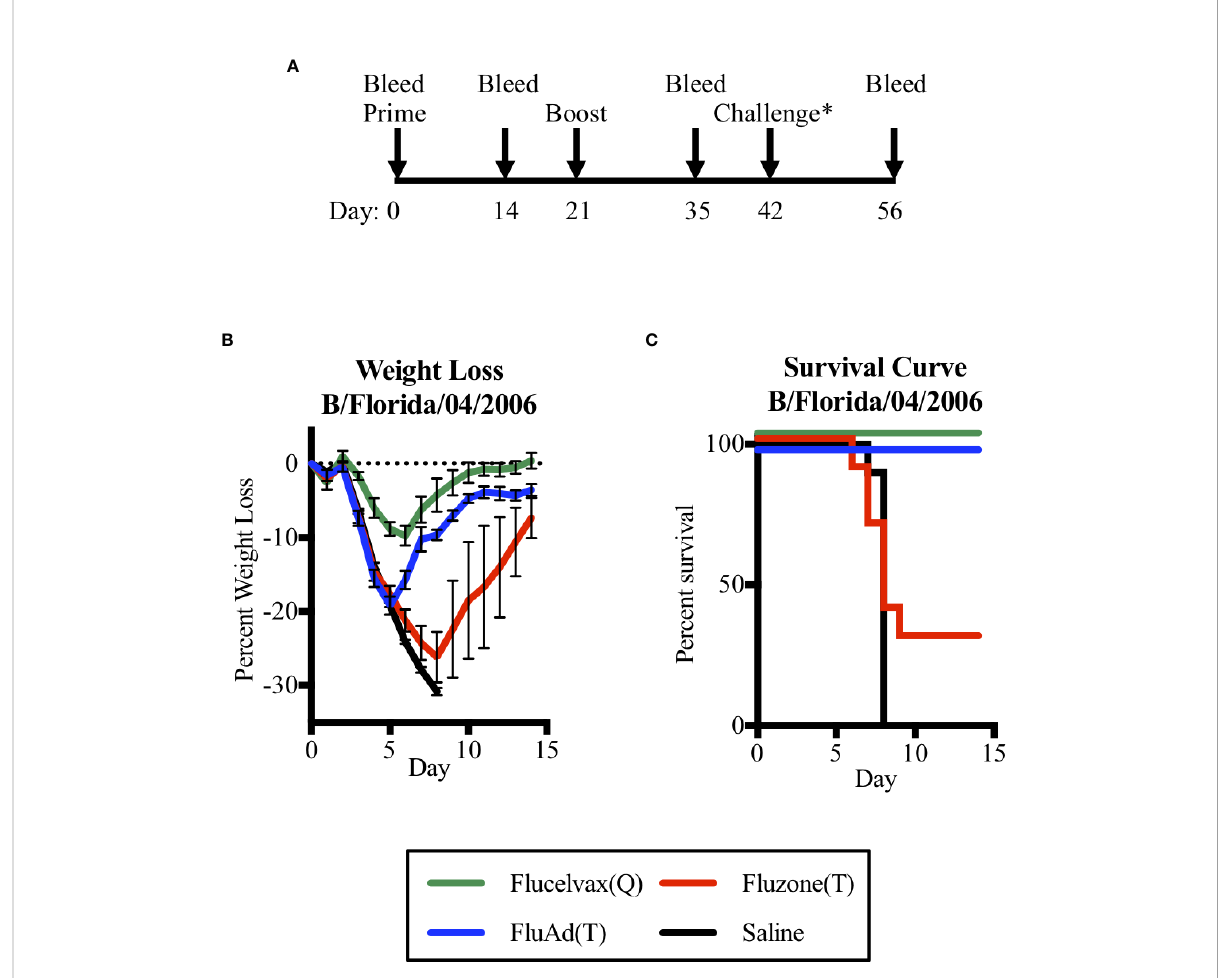
FIGURE 3 Assessing mice survival and weight loss between quadrivalent (Q) and trivalent (T) vaccines following in fl uenza B (Yamagata-lineage) challenge. (A) Immunization and challenge schedule with prime and boost (day 0 and 21), intranasal challenge (day 42), and bleeds (day 0, 14, 35, and 56). (B) Weight-lost curves for 14 days following intranasal in fl uenza B-Y challenge. (C) Corresponding survival curves. Vaccines were Flucelvax (Q) (green), Fluad (T) (blue) and Fluzone (T) (red) with saline control (black). Yamagata-lineage challenge virus was mouse-adapted B/Florida/ 04/2006. Challenge* denotes on the timeline when the challenge virus of Mouse Adapted B/Florida/04/2006 (Yamagata Lineage) was administered